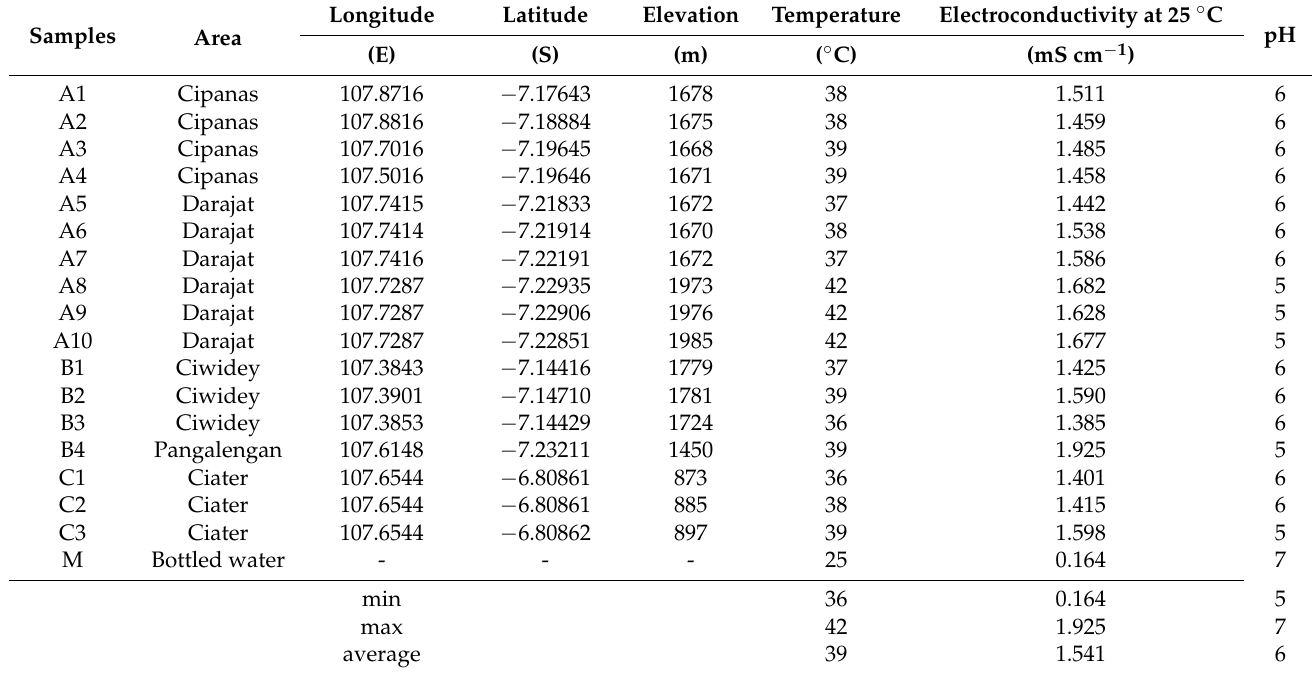
Table 1. The location, physical and chemical properties of the water samples.